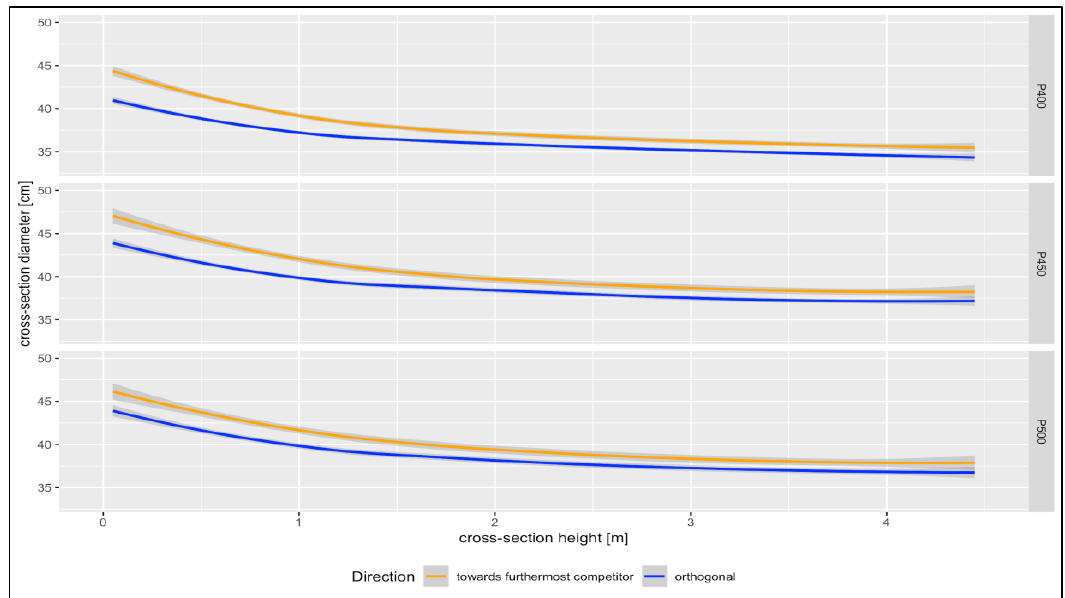
Figure 3. Average orthogonal profiles by treatment, based on ‘local regression’, with ‘standard error bounds’. On average, stem compression in the direction of the nearest competitor is well-marked, and stems are larger as the distance to the nearest competitor increases (from 4.0 cm (P400) to 5.0 cm (P500)).